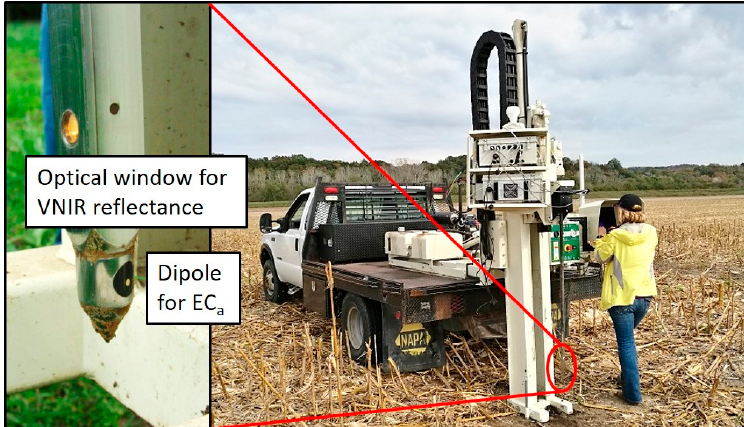
Figure 1. Veris P4000 instrument in field operation, collecting visible and near-infrared (VNIR) spectra, apparent soil electrical conductivity (EC a ), and cone index (CI) penetrometer readings. A close-up view shows the probe tip, including optical window and EC a dipole.